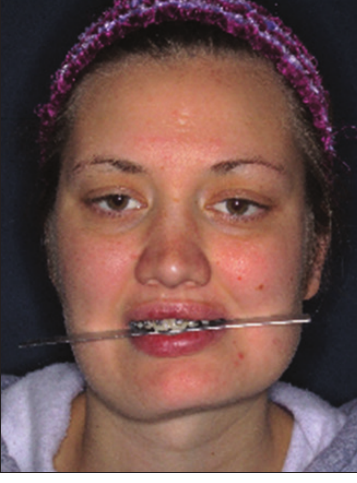
Figure 2b. Progress frontal